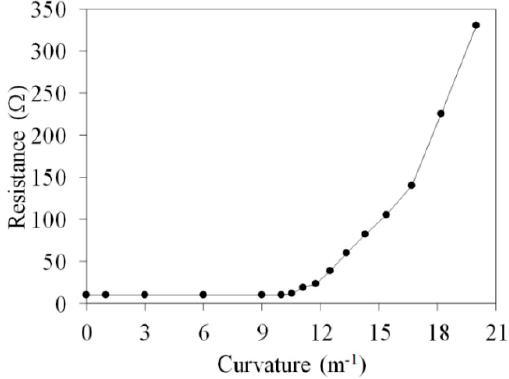
Figure 12. Relationship between resistance and curvature for the FTG.